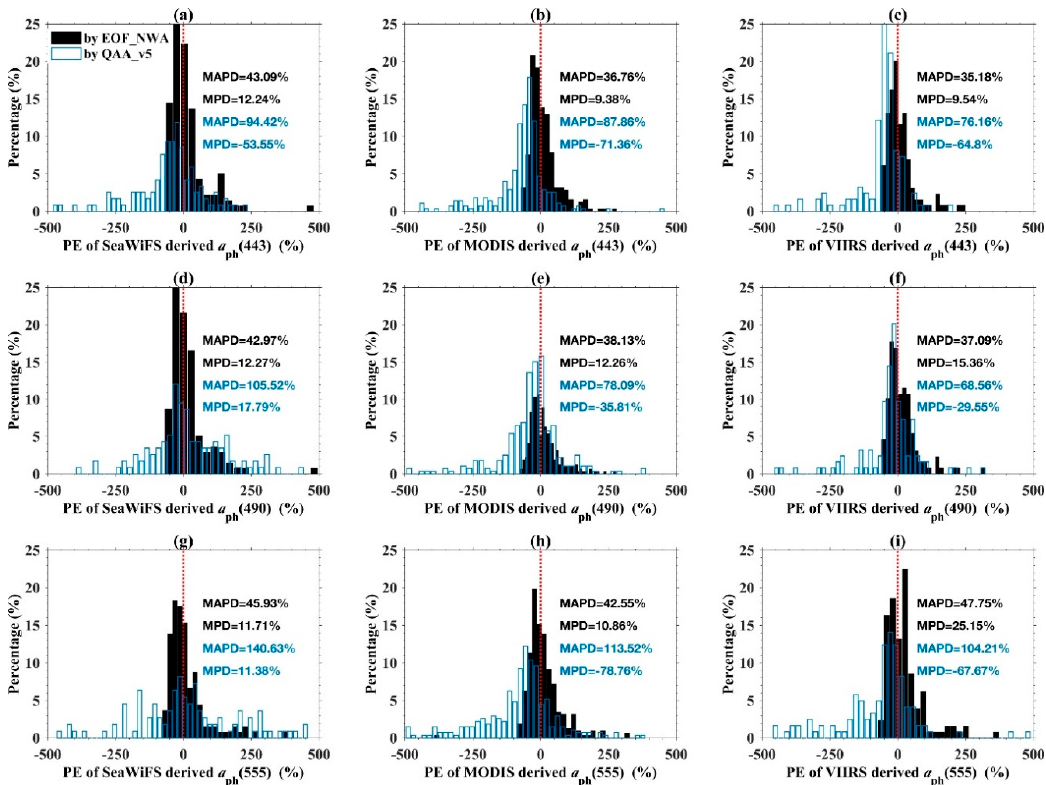
Figure 8. Histograms of percentage error of satellite derived a ph ( λ ) ( λ = 443, 490, and 555 nm) for SeaWiFS, MODIS and VIIRS compared to measured a ph . The a ph ( λ ) derived by IOP model of EOF_NWA and QAA v5 was shown in black and blue bars, respectively.